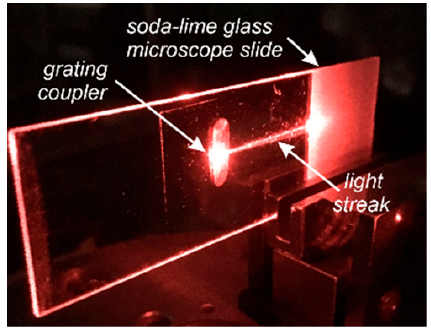
Figure 17. Slab waveguide excited with the use of grating coupler. λ = 677 nm, Λ = 417 nm.